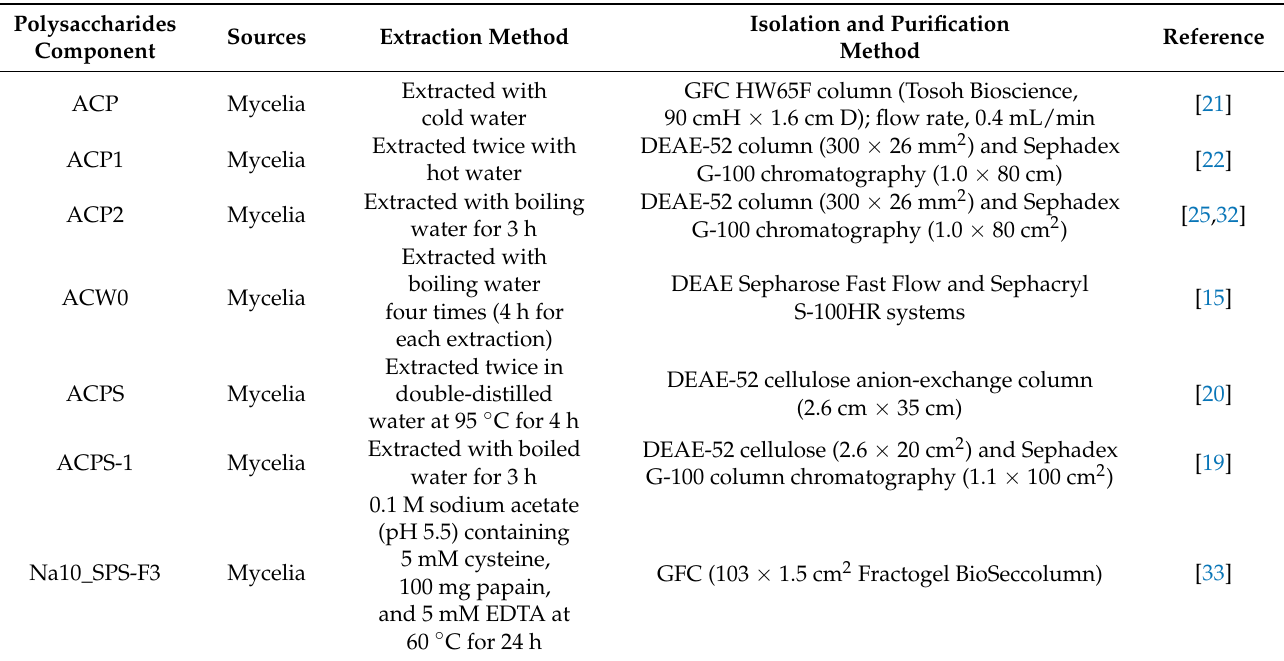
Table 1. Preparation procedures of polysaccharides from A. cinnamomea in recent publications.